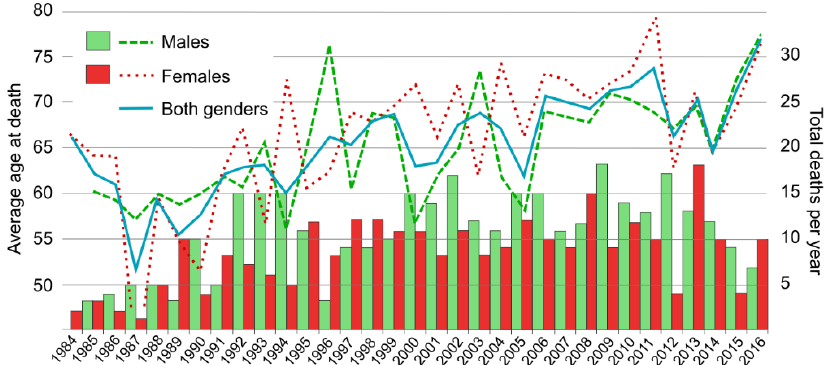
Figure 1. Average age at death (lines) and number of deaths (bars) due to granulomatosis with polyangiitis (GPA) in Spain by gender: 1984–2016.